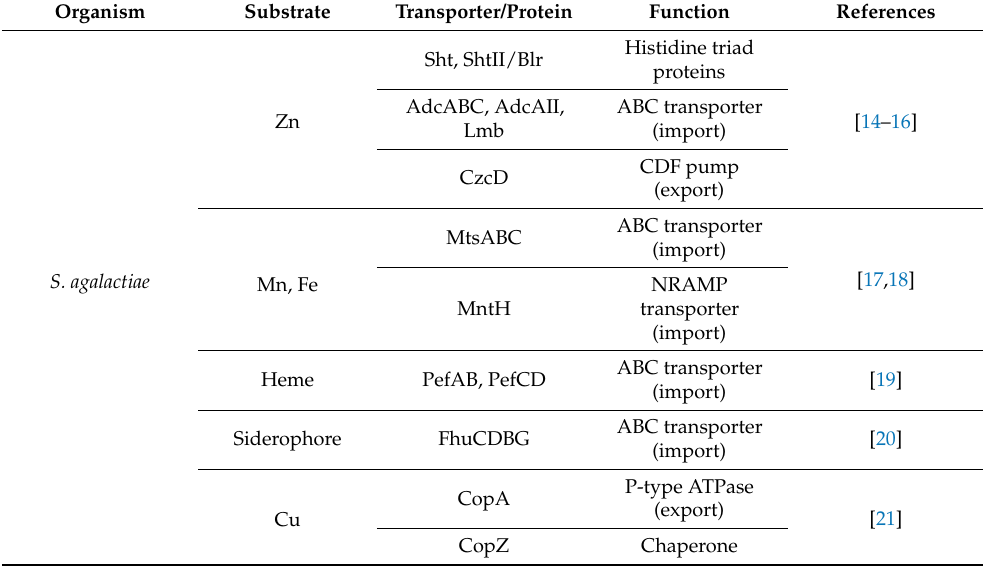
Table 2. Characterized metal transport systems in pathogenic Streptococcus spp. organized by species and